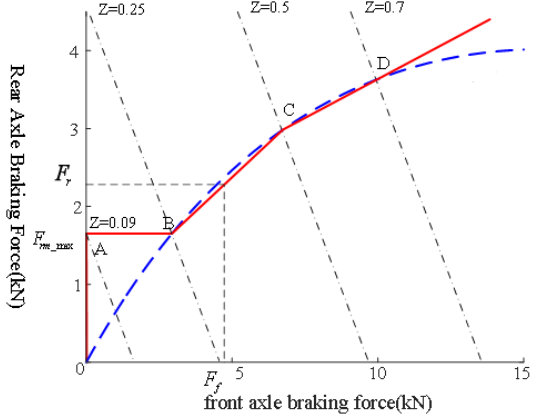
Figure 7. Battery–front motor–CVT joint efficiency map.